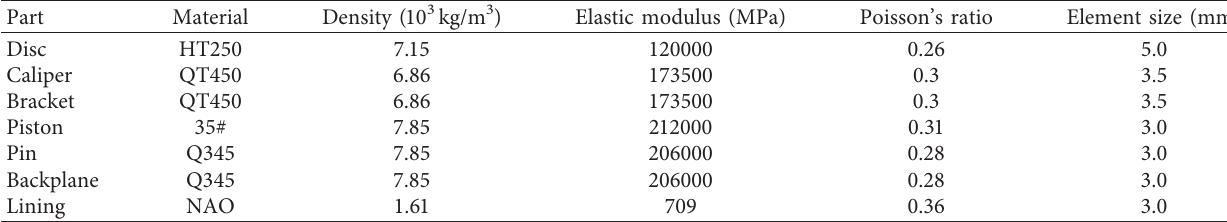
Figure 1: Original model and FEM of the brake system. Table 1: Material properties of parts of the brake system.